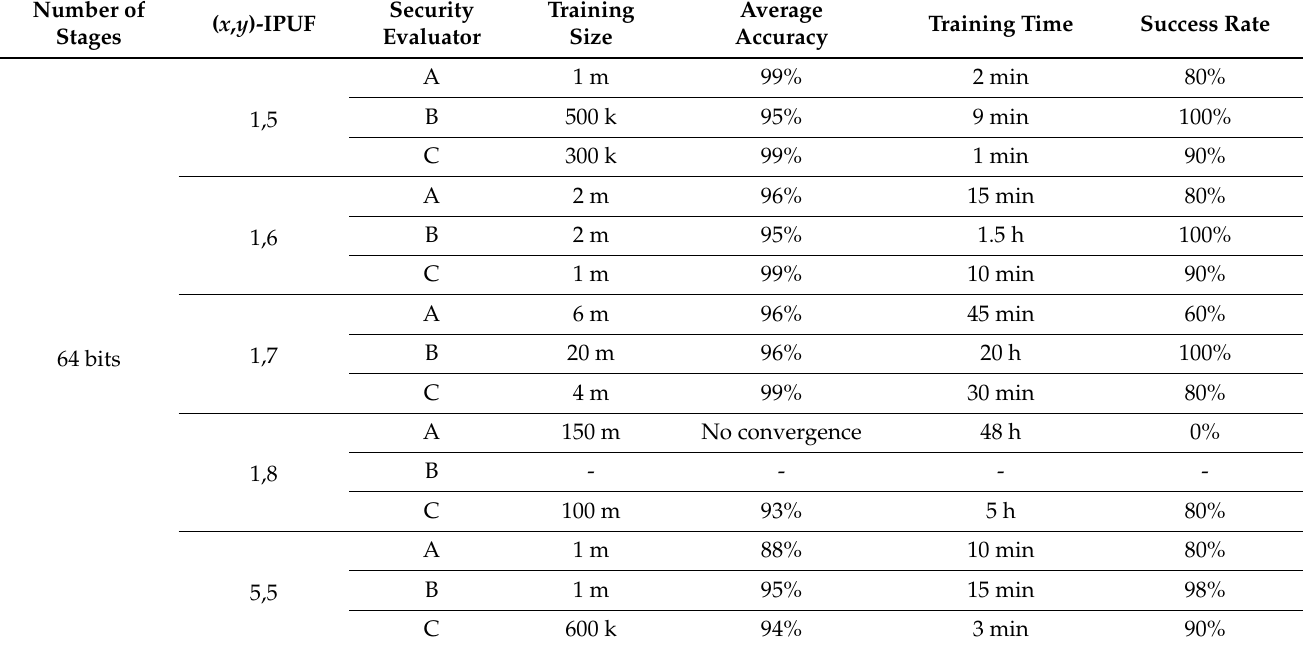
Table 2. Experimental results on attacking the IPUF dataset (Method “A” refers to the method in